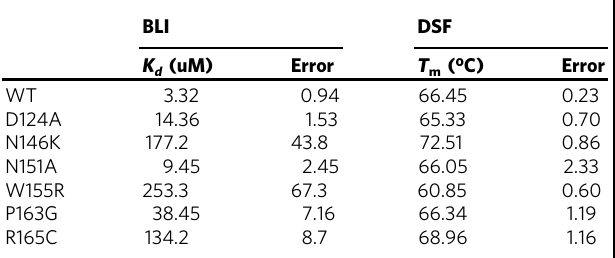
Fig. 2 FXN-ISCU interactions and FXN mutagenesis. a . Interactions of FXN (orange) with both NFS1 subunits (NFS1, light slate; NFS1 ′ , blue). Residues studied by site-directed mutagenesis are asterisked. Dashed lines denote potential hydrogen bonds. b . Interface of FXN β -sheet with ISCU LPPVK-region and NFS1 Cys-loop. c . Interface of FXN with ISCU Ala-loop, LPPVK-region, and Zn 2 + ion (sphere). Inset shows viewpoints of panels b and c within SDAUF- Zn 2 + complex Table 1 Dissociation constant ( K d ) and melting temperature ( T m ) of FXN